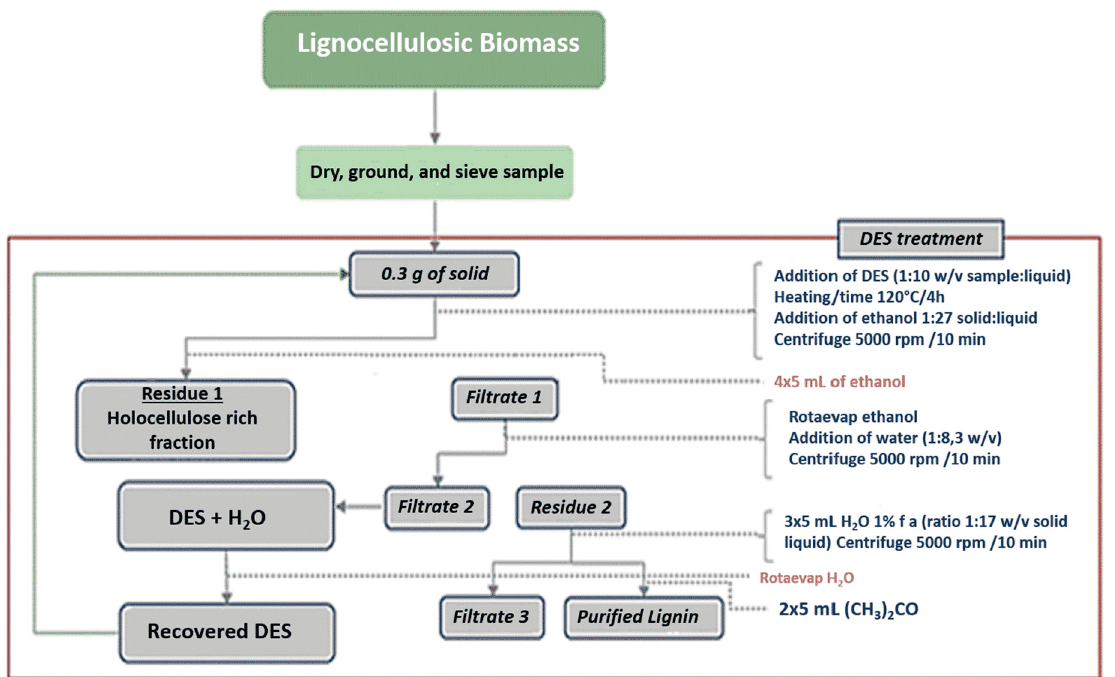
Figure 2. The general procedure of the fractionation of lignocellulosic biomass.